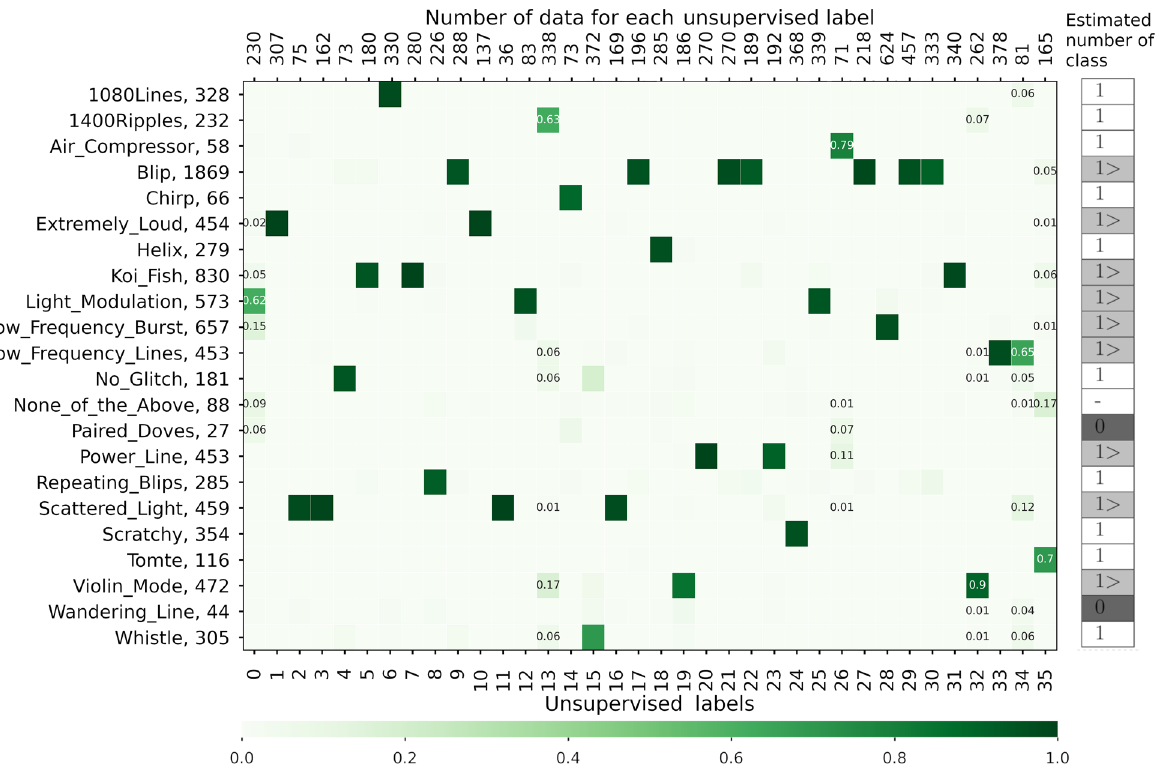
Figure 4. Confusion matrix of the classification results of the proposed architecture. The vertical axis of the confusion matrix represents the labels and number of data in the Gravity Spy dataset. The lower and upper horizontal axes denote the number of images classified into the unsupervised classes and the labels of the unsupervised classes, respectively. Each column of the confusion matrix is coloured using the ratio of the Gravity Spy-labelled images classified into the unsupervised class ( i ). In addition, the classes that are separated from the Gravity Spy labels on the confusion matrix, such as classes (0), (13), (26), (32), (35), and (36), also show the ratio values in the matrix. The potential number of classes on Gravity Spy labels which are estimated by unsupervised learning are shown in the right column of the figure. The notation “1” (in white cells) indicates that the number of classes labelled by the Gravity Spy matches the result of the unsupervised learning, and the inequality sign (in light grey cells) indicates that the class is separated into multiple classes in the unsupervised learning. The notation “0” (in dark grey cells) indicates an unclassified class in this training and dataset, and “–” notation indicates that they do not belong to any class of the unsupervised